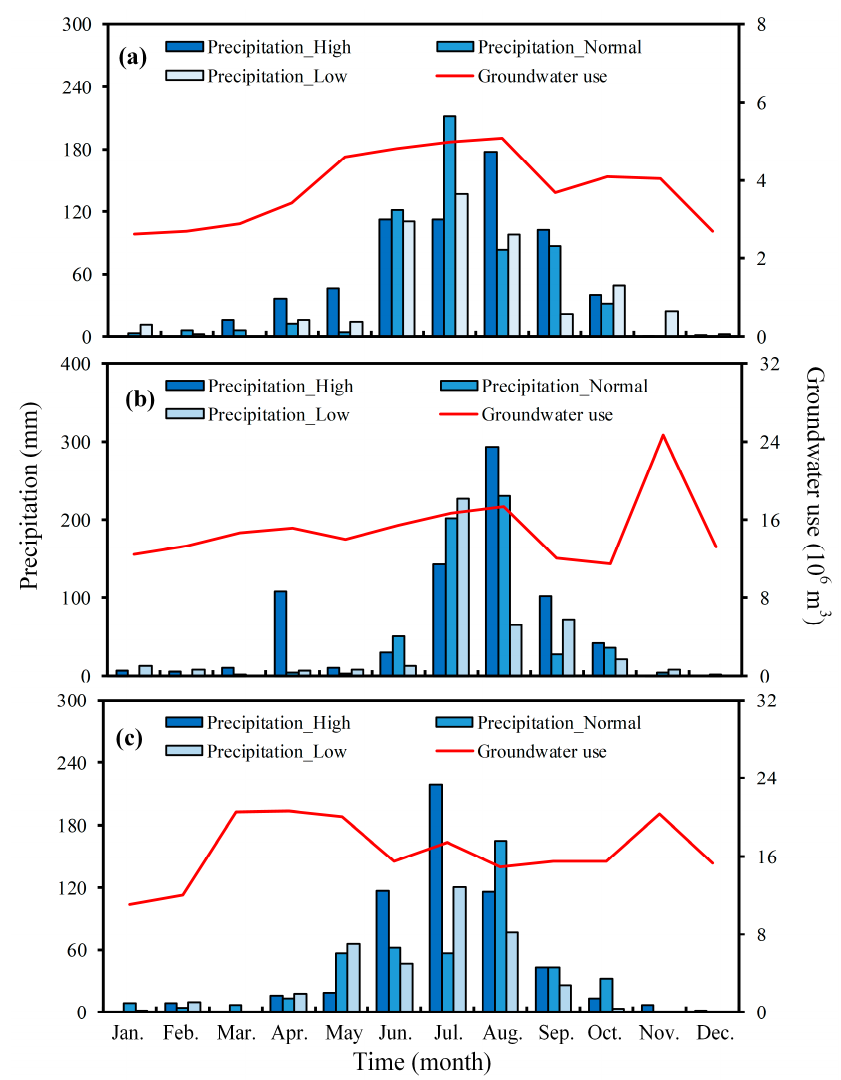
Figure 8. The precipitation under three seasons and groundwater use in 2014 in three typical districts.